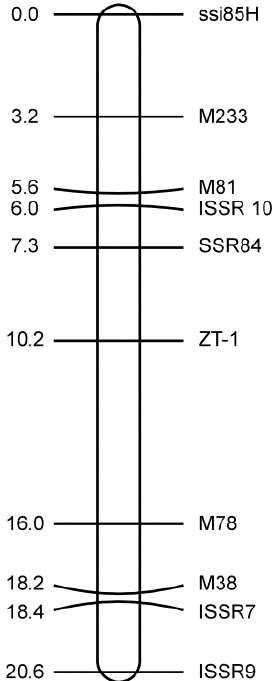
Figure 4. Linkage map of the zero tannins zt-1 gene flanked by six SSR and three ISSR markers. The locus name and corresponding locations are indicated on the right side and the genetic distances between them are indicated on the left side.